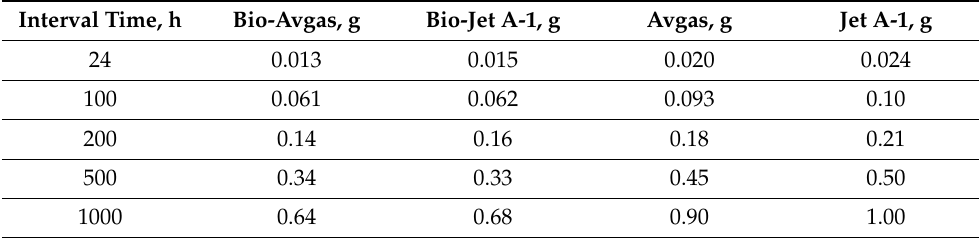
Table 6. Fuels weight reduction during the tests (in grams) for the AFM